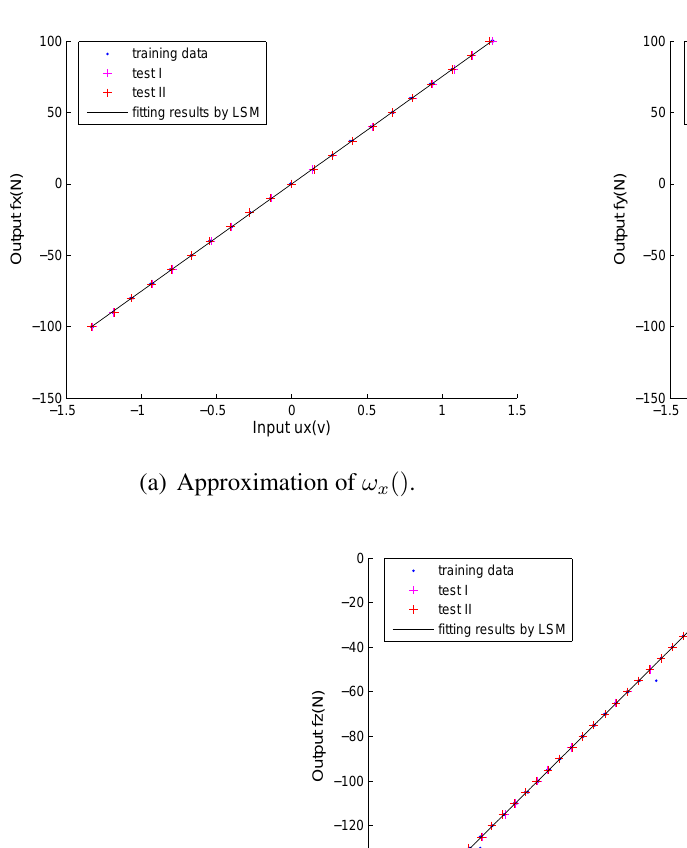
Figure 6. Linear fittings of non-coupling